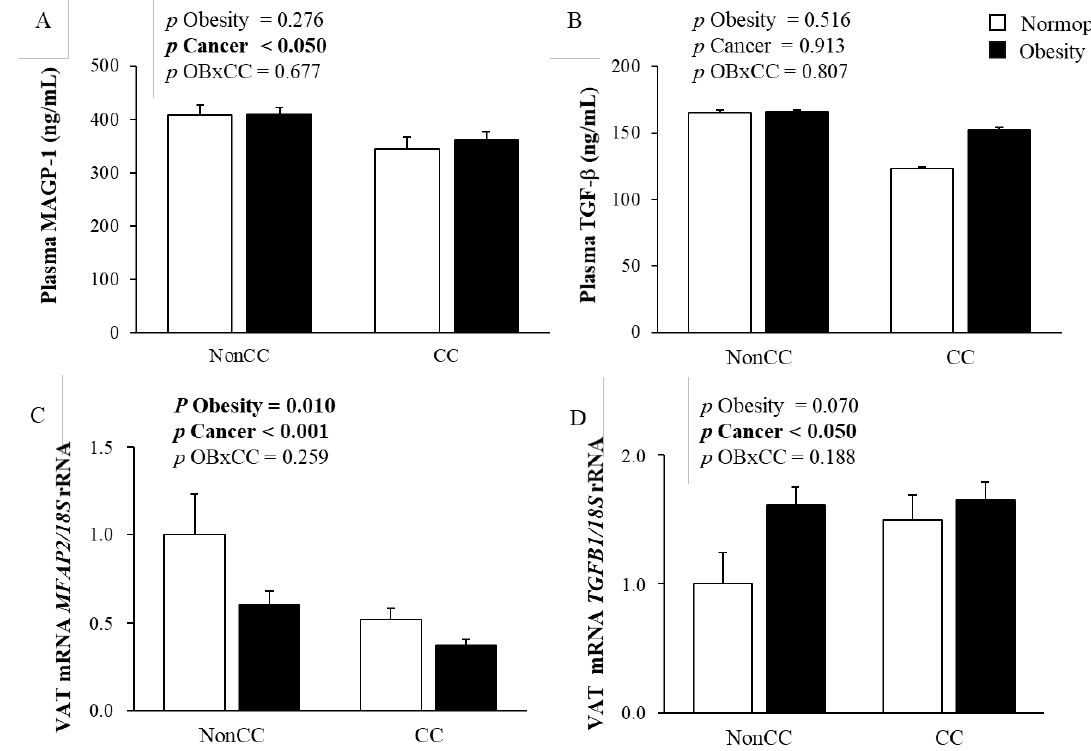
Figure 1. MAGP-1 ( A ) and TGF- β ( B ) circulating levels in normoponderal (NP) volunteers and patients with obesity (OB) with and without colon cancer (CC). MFAP2 ( C ) and TGFB1 ( D ) gene expression levels in NP volunteers and patients with OB with and without CC. Differences between groups adjusted for age were analyzed by two-way ANCOVA. Bars represent the mean ± SEM.